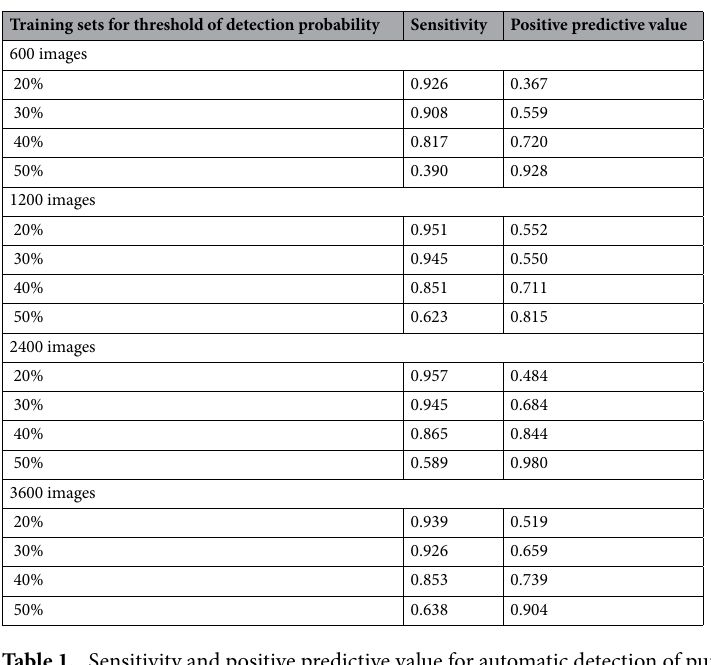
Table 1. Sensitivity and positive predictive value for automatic detection of punctate white matter lesions by the threshold of detection probability for each training set of composite images.